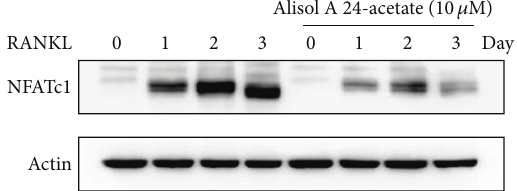
Figure 4: Alisol A 24-acetate inhibits RANKL-induced NFATc1 expression. BMMs were pretreated with alisol A 24-acetate (10 𝜇 M) for 1h and then stimulated with RANKL (10ng/mL) for the indicatedtime.CelllysateswereresolvedbySDS-PAGE,andwestern blotting was performed with anti-NFATc1 and anti-actin antibodies as